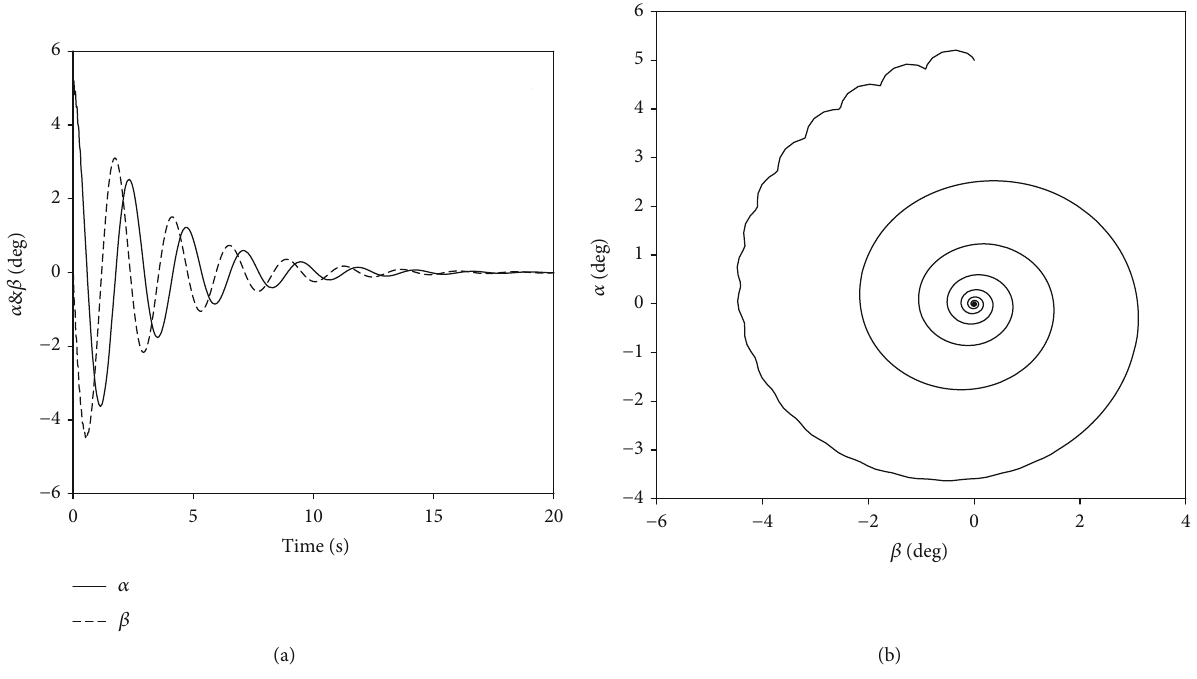
= 0 : 23 . (a) Curves of angle of attack and sideslip. (b) Stable coning motion. Figure 4: Simulation results for k ω